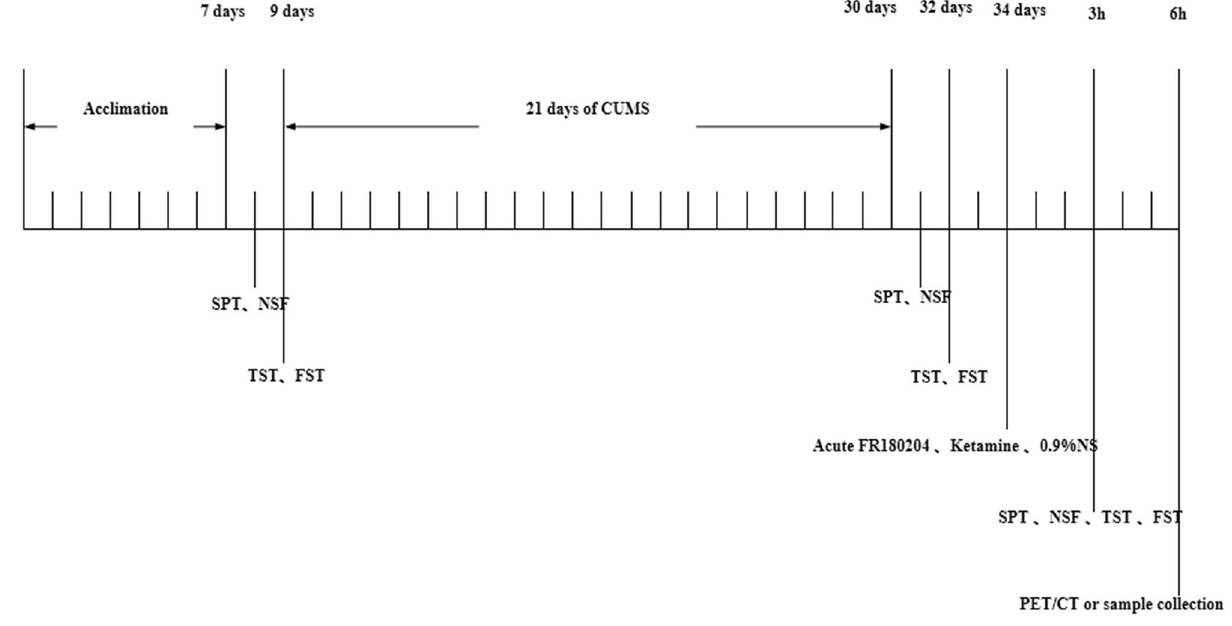
Figure 7. Flowchart of experimental